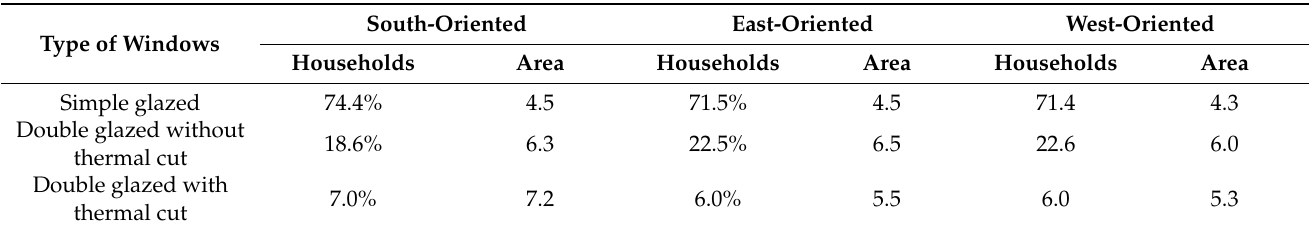
Table 2. Typology of glazed windows by facade orientation—Portugal, 2010, adapted from [34]. Area—average area per household orientation [m 2 ].